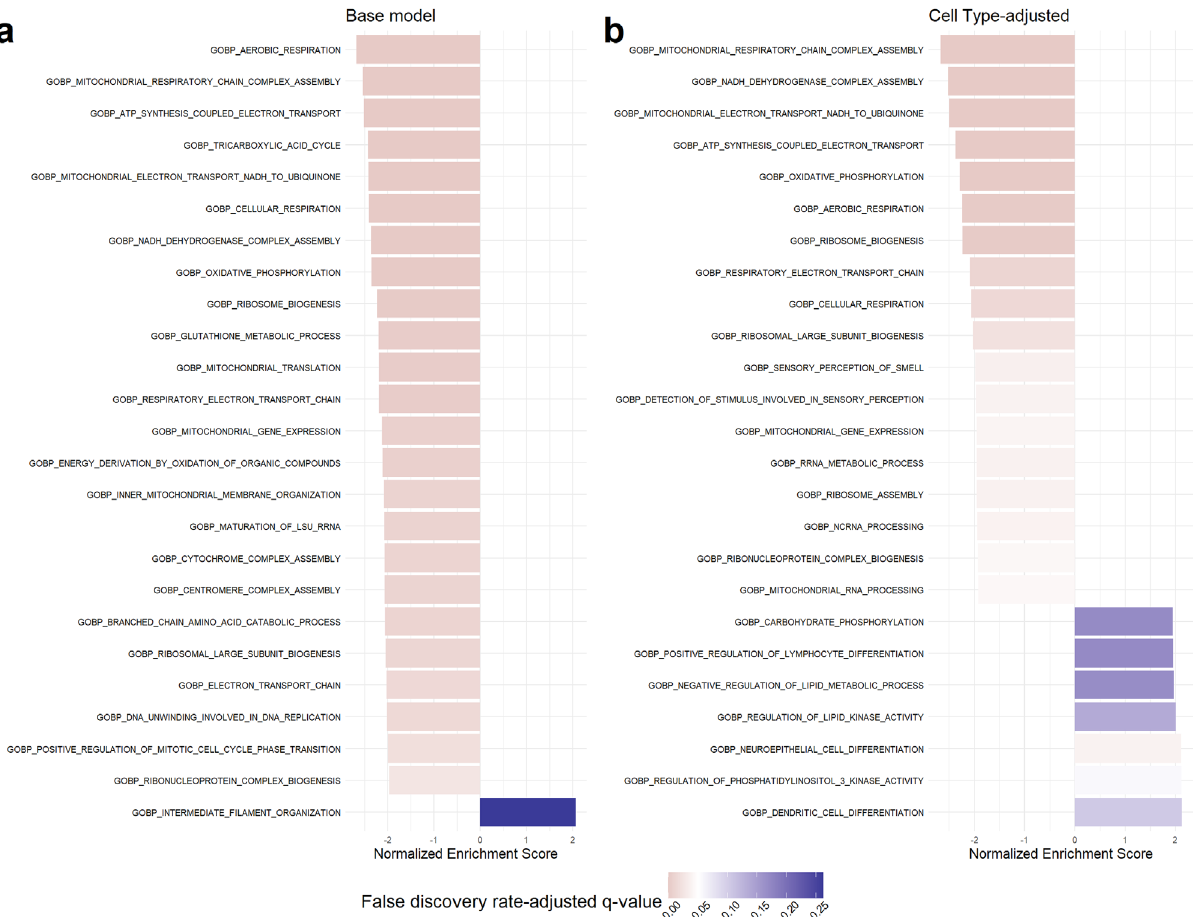
Fig. 5 Preeclampsia case – control differential expression enrichment analysis. Top Gene Set Enrichment Analysis pathways from the Gene Ontology: Biological Processes database results for the differential expression analysis by preeclampsia case – control status. Results arranged by descending magnitude of the absolute value of the normalized enrichment score. Pathways colored red are signi fi cant at a false discovery rate-adjusted (FDR) q value of 0.05 whereas pathways in blue are statistically insigni fi cant. a Top pathways from the cell type-unadjusted analysis. b Top pathways from the cell type- adjusted